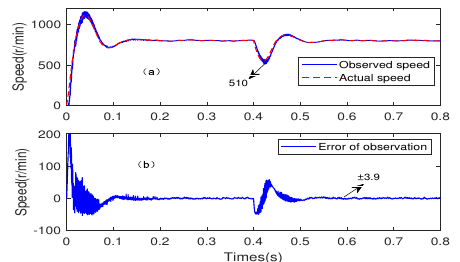
Figure 19. The speed response of PI regulator under 800 r/min. ( a ) Observed speed and actual speed. ( b ) Estimation error curve.